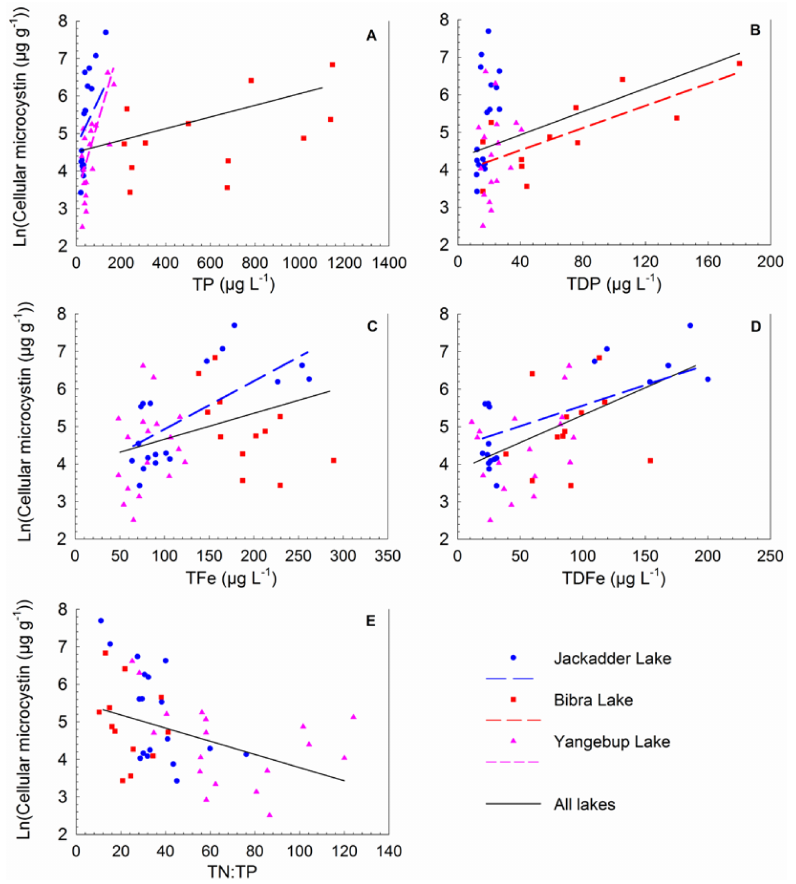
Figure 7. The correlations between cellular microcystin concentration and (a) TP, (b) TDP, (c) TFe, (d) TDFe, (e) TN:TP in Jackadder, Bibra and Yangebup lakes during the study period. Regression curves for each individual lake were calculated by linear mixed models with site and date as random factors on data from each lake (broken lines) while all data points were combined for the overall regression using a linear mixed model adding lake as random factor (solid line). All regression shown are p < 0.05, except for the regression calculated for all lakes combined in (a) , which is p <